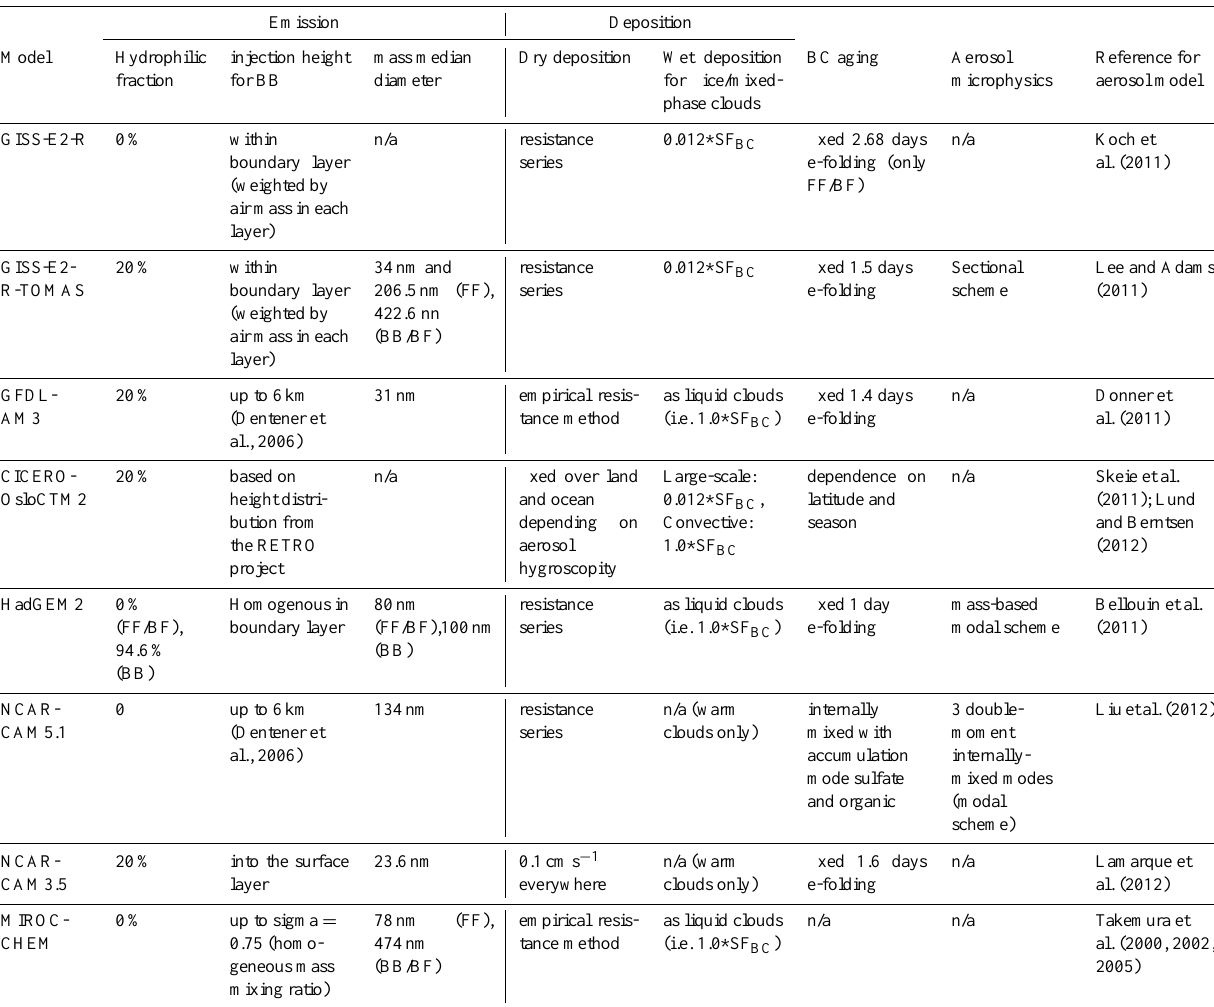
Table 2. BC modeling methodology. SF BC stands for in-cloud scavenging fraction of hydrophilic BC. FF is for fossil fuel emissions, BF for biofuel emissions, and BB for biomass burning